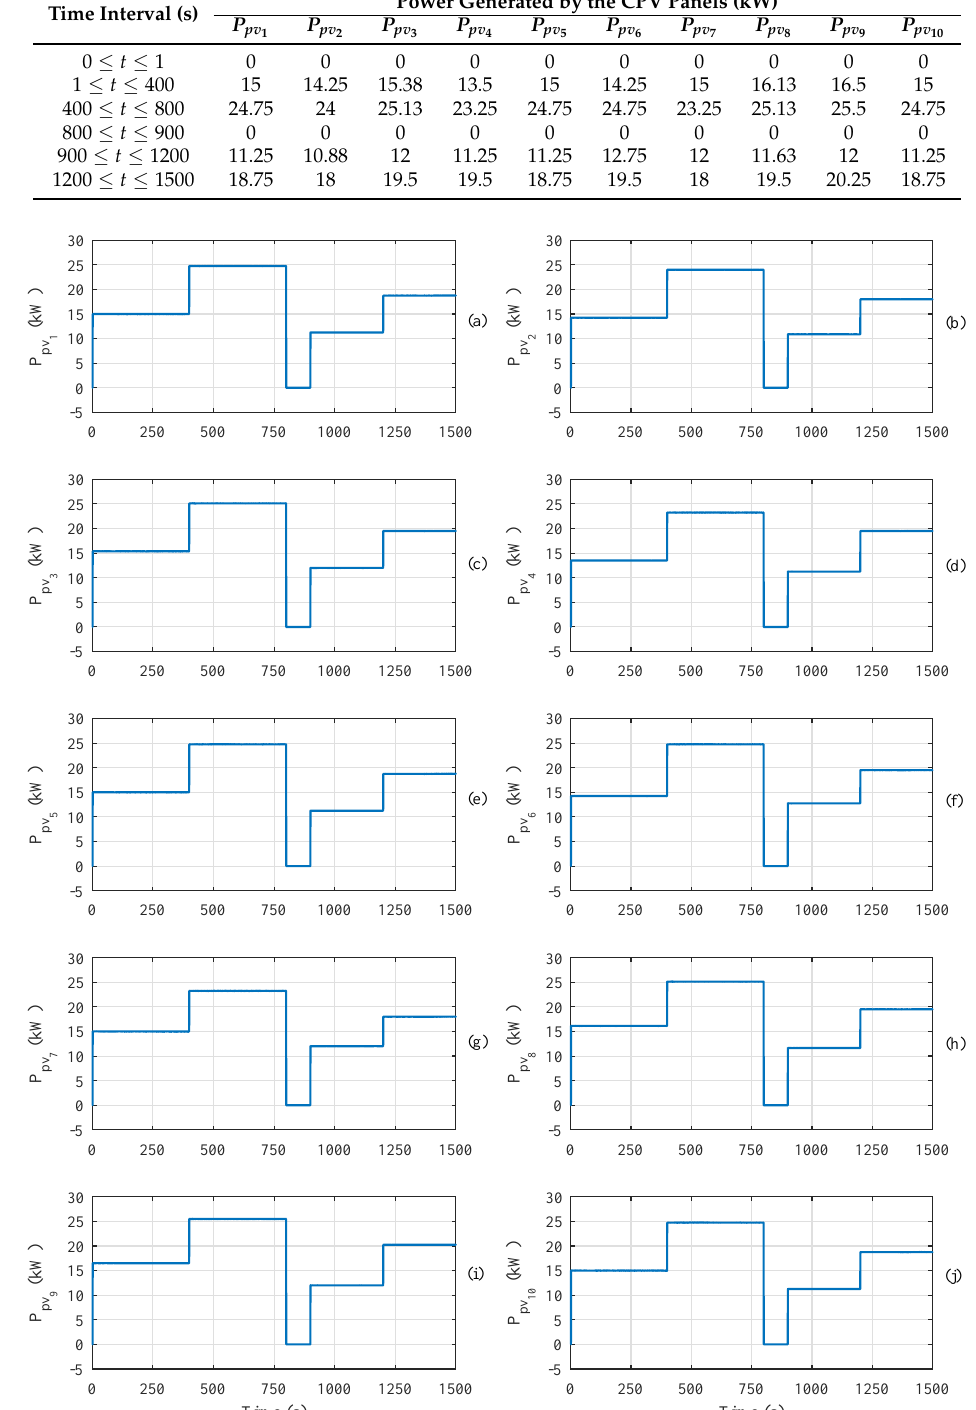
Table 3. Power generated by the concentration photovoltaic (CPV) panels over time, assuming a DC-link voltage of 750 V.